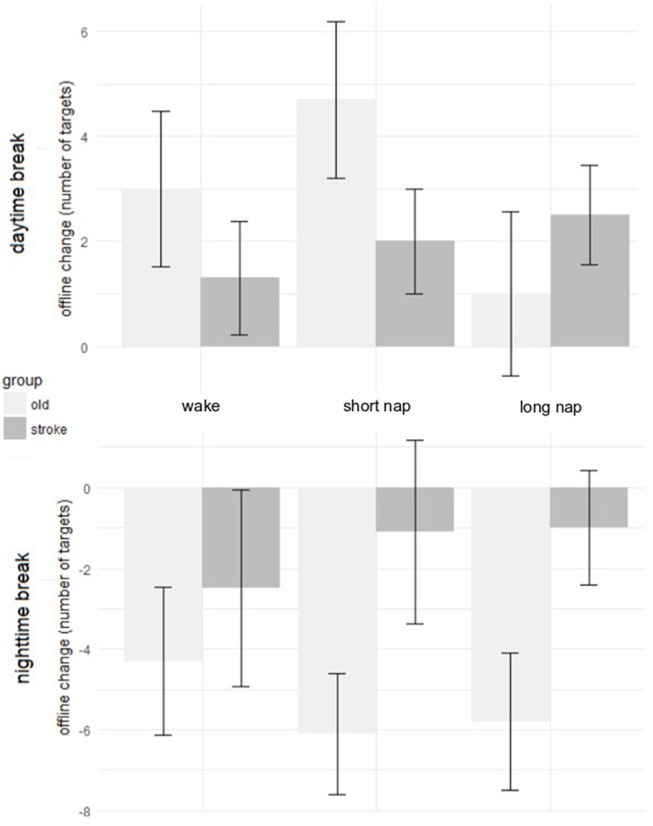
Offline change during daytime rest (Top) and after a night of sleep (Bottom) in healthy older adults (light gray) and individuals after stroke (dark gray). The error bars represent the standard error of the mean.